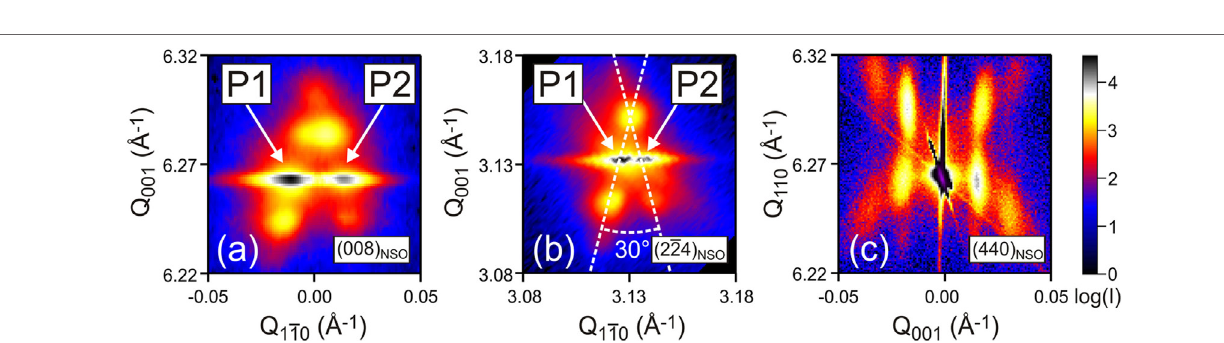
FigUre 8 | (a) Vertical and (b) lateral piezoresponse force microscopy amplitude images (1 µm × 1 µm) of a 28 nm thick K 0.9 Na 0.1 NbO 3 film on (110) NdScO 3